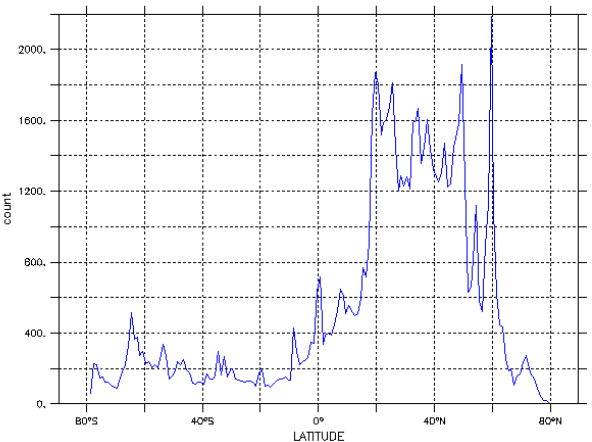
Figure 4. The number of SOCAT data points per 1° latitude by 1° longitude grid box for the years 2000 to 2007 shown as a function of latitude. This figure highlights the paucity of data in the Southern hemisphere.